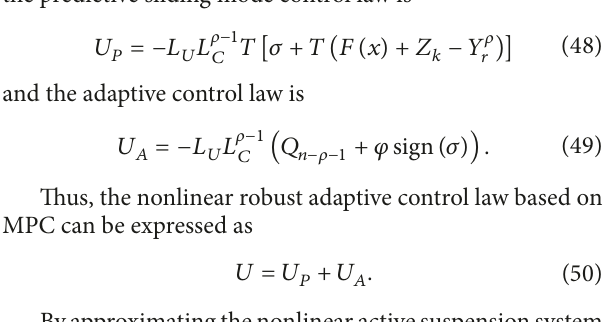
Table 1: Simulation parameters ( 𝑖 = 1,2, 3, 4 ).